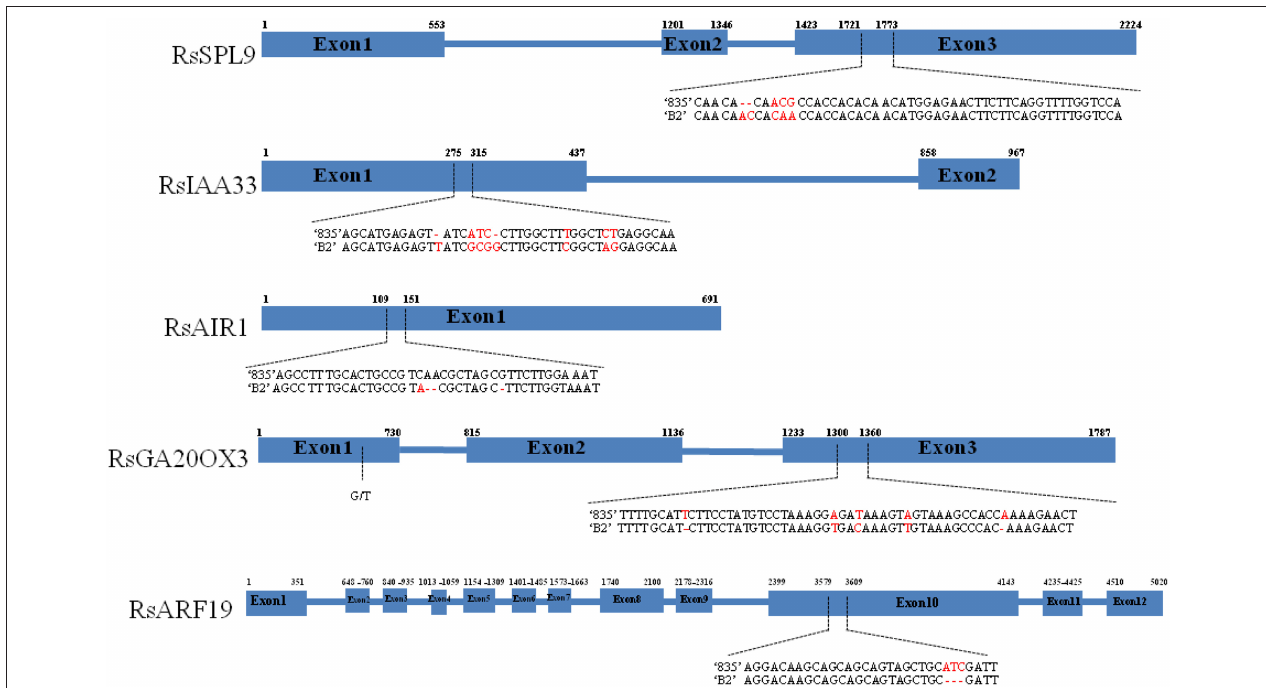
FIGURE 2 | Nucleotide polymorphisms of RsSPL9, RsIAA33, RsAIR1, RsGA20OX3, and RsARF19 between “835” and “B2.” Blue boxes and blue lines indicate exons and introns, respectively. Dashed arrows indicate nucleotide variations. Numbers above the boxes indicate exon start and stop sites.